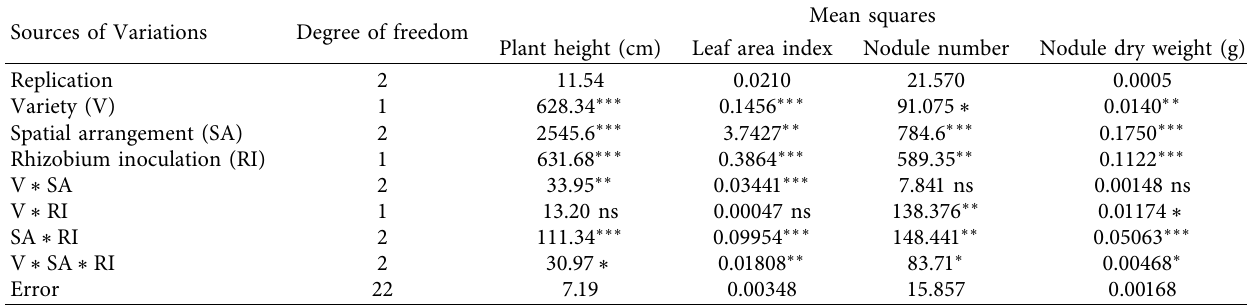
Table 6: Mean squares from analysis of variance (ANOVA) for plant height, leaf areas index, the number of nodules per plant − 1 , and nodule dry weight per plant − 1 of common bean.